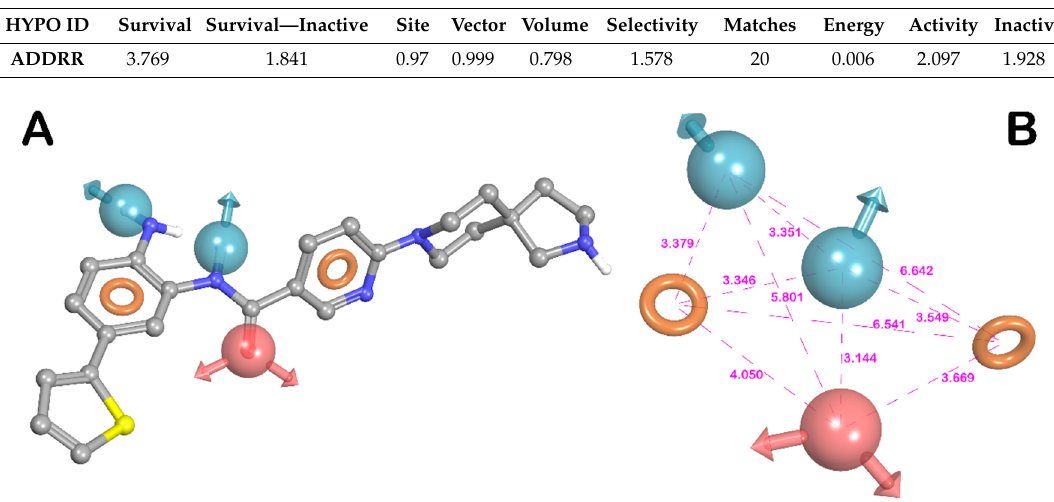
Table 1. The different scoring parameters for the best pharmacophore hypothesis, matching all 20 highly active compounds used.